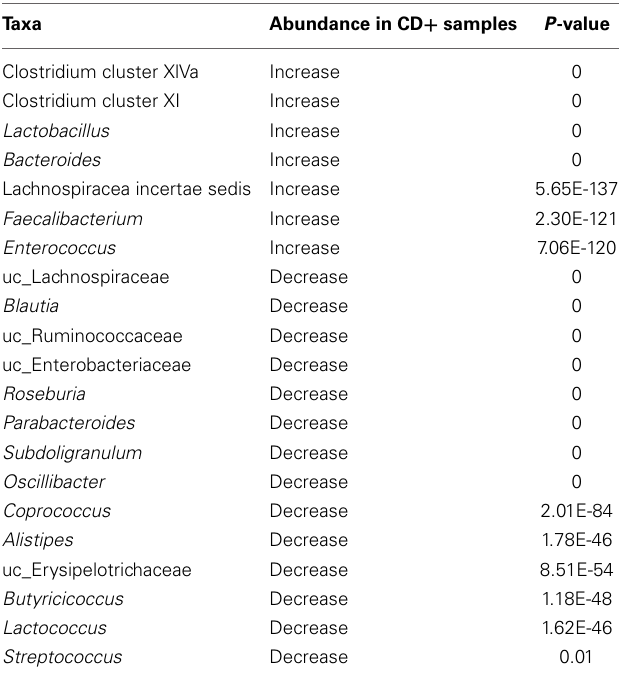
Table 2 | Differential taxa abundance between CD − (during time points of A–E patients) and CD + (F16_D, F_after, G_before, G4_D, G_after, H35_D and H38_D)